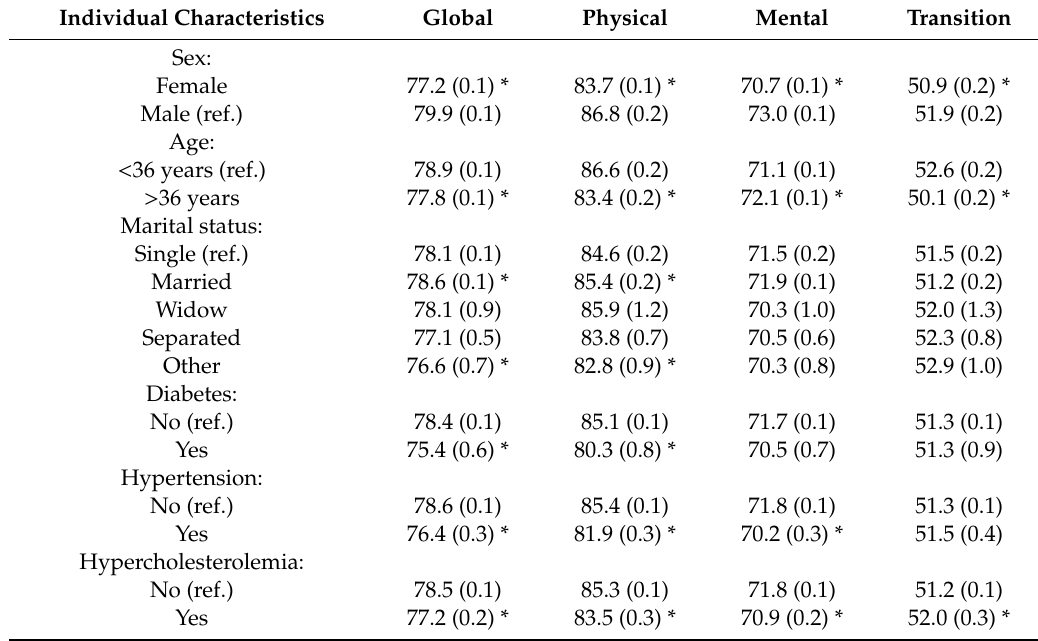
Table 2. Mean scores of the Short Form-36 (SF-36) global scale and subscales according to the baseline characteristics of